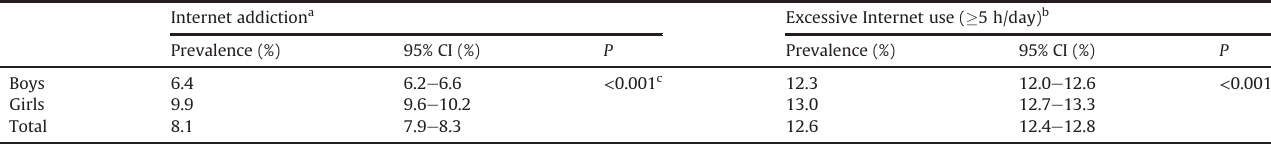
Table 1 Prevalence of Internet addiction and exessive Internet use among Japanese adolescents, based on sex. Internet addiction